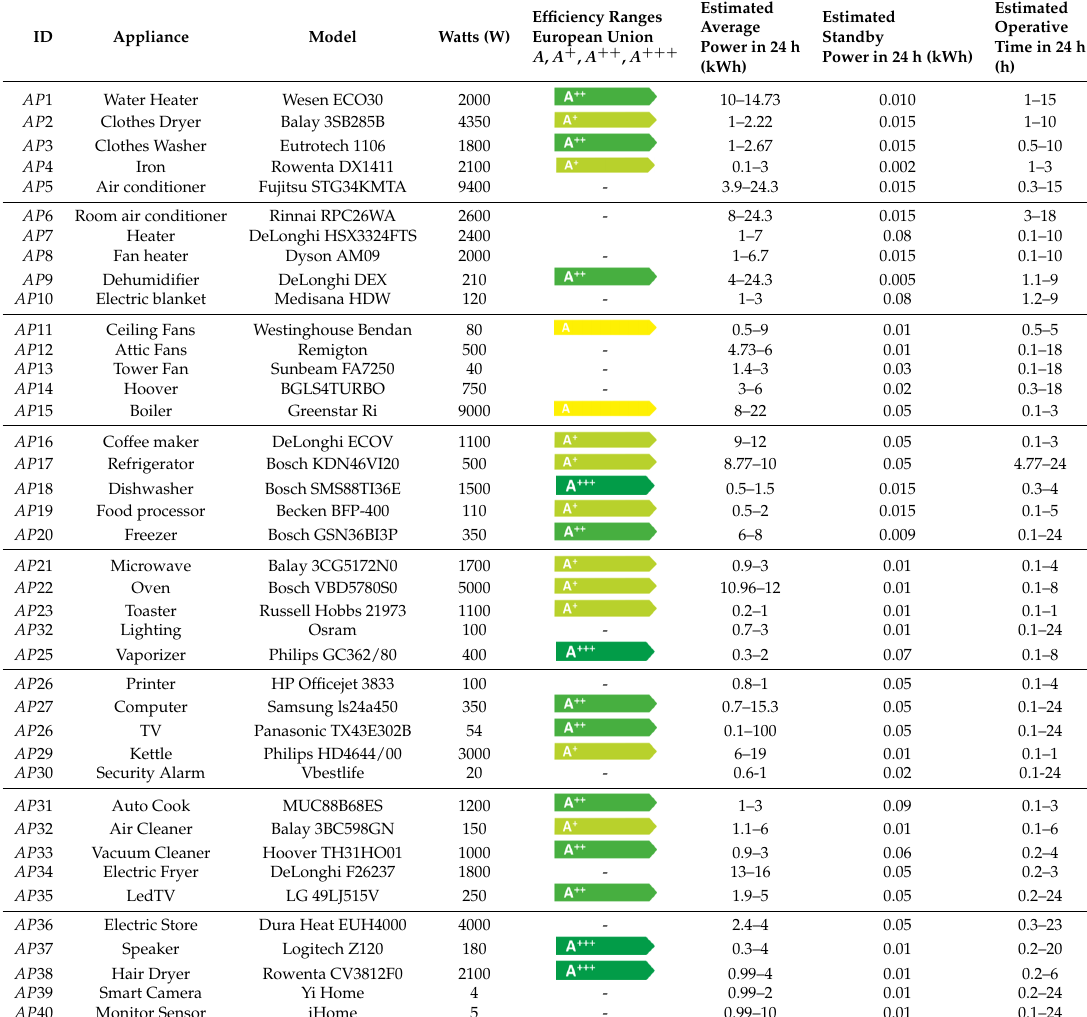
Table 2. Common household appliance energy use.